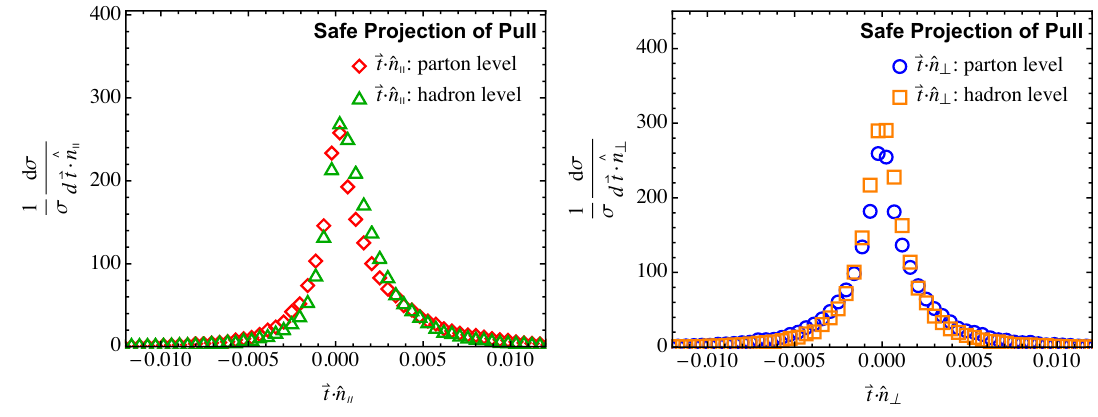
and ~t (cid:1) ^ n ? distributions, left and right respectively, k